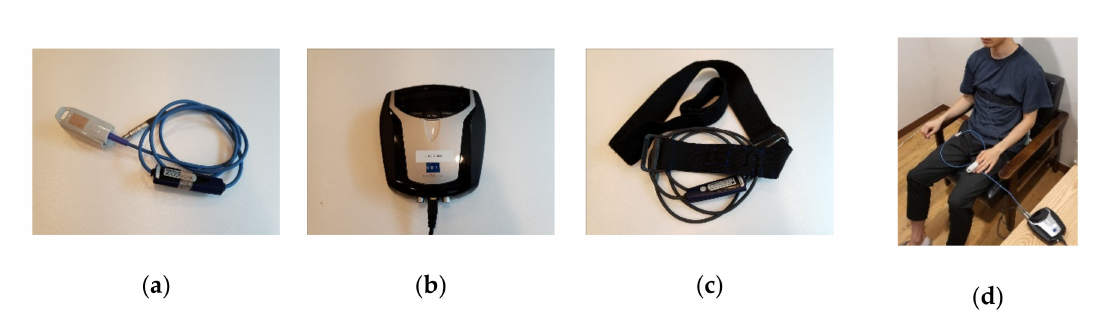
Figure 3. Experimental equipment: ( a ) finger-Clip BVP Sensor; ( b ) NeXus-10 MKII; ( c ) chest-Band Respiration Sensor; and ( d ) signal